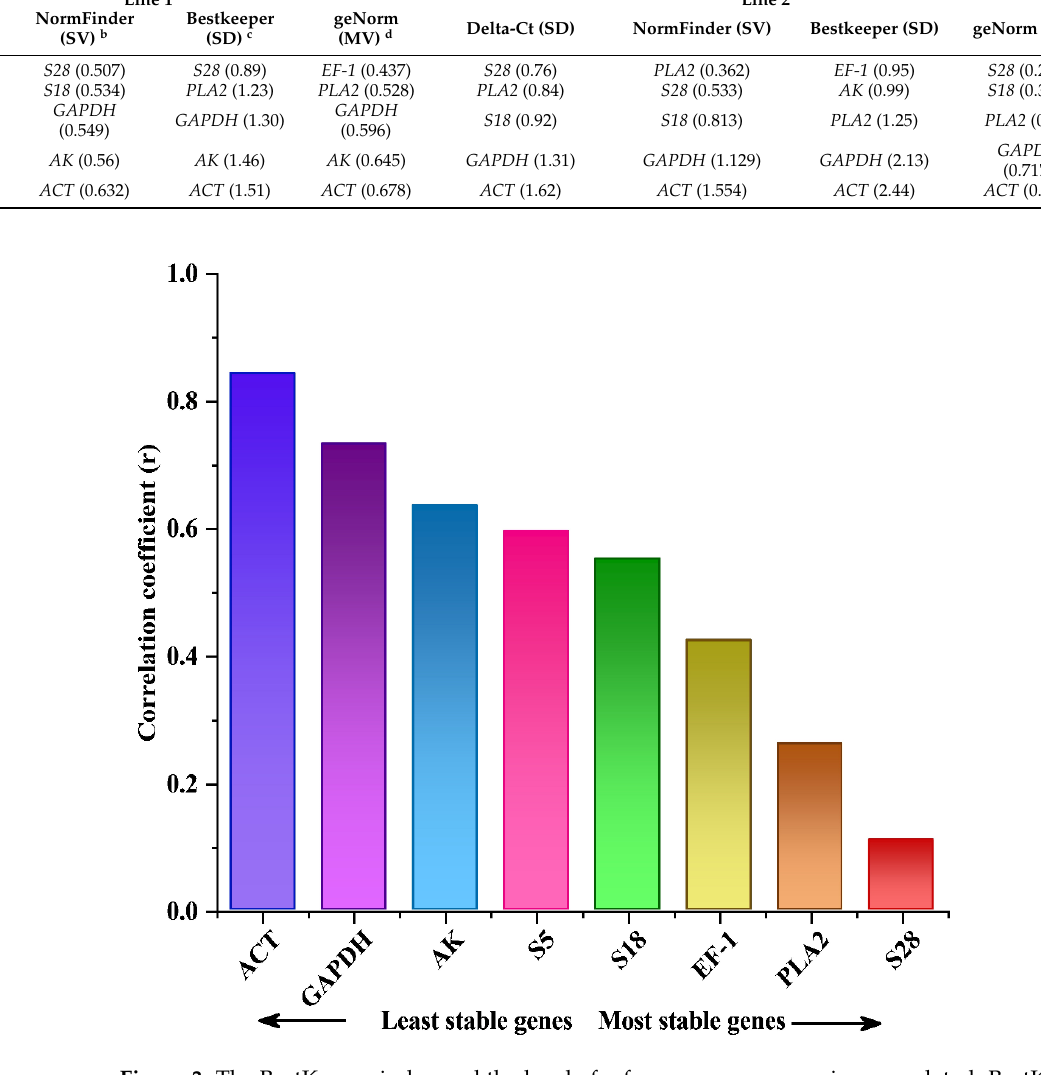
Figure 3. The BestKeeper index and the level of reference gene expression are related. BestKeeper was used to examine the stability of the eight reference genes.